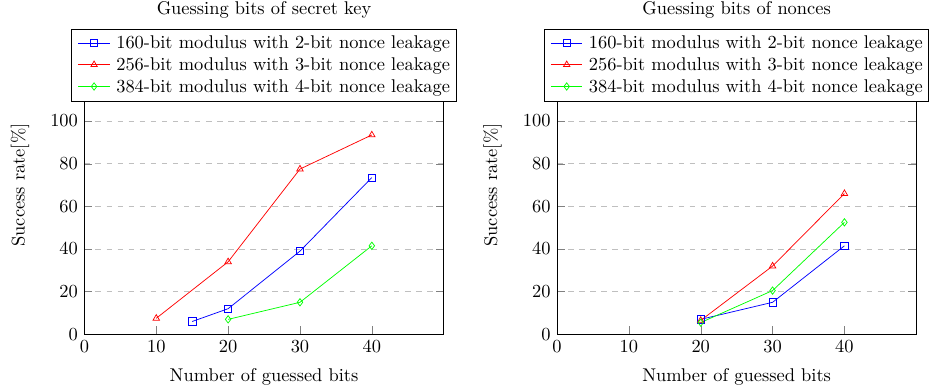
Figure 2: Experimental results: guessing bits of the secret key vs. of the